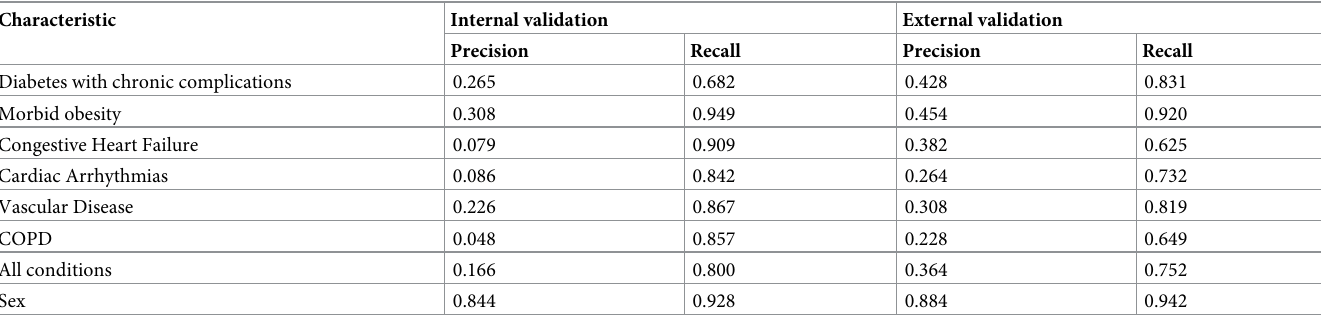
Table 3. Precision and recall of Multi-Task Deep Learning HCC-Based Comorbidity and Sex Predictions for Internal and External Cohorts.